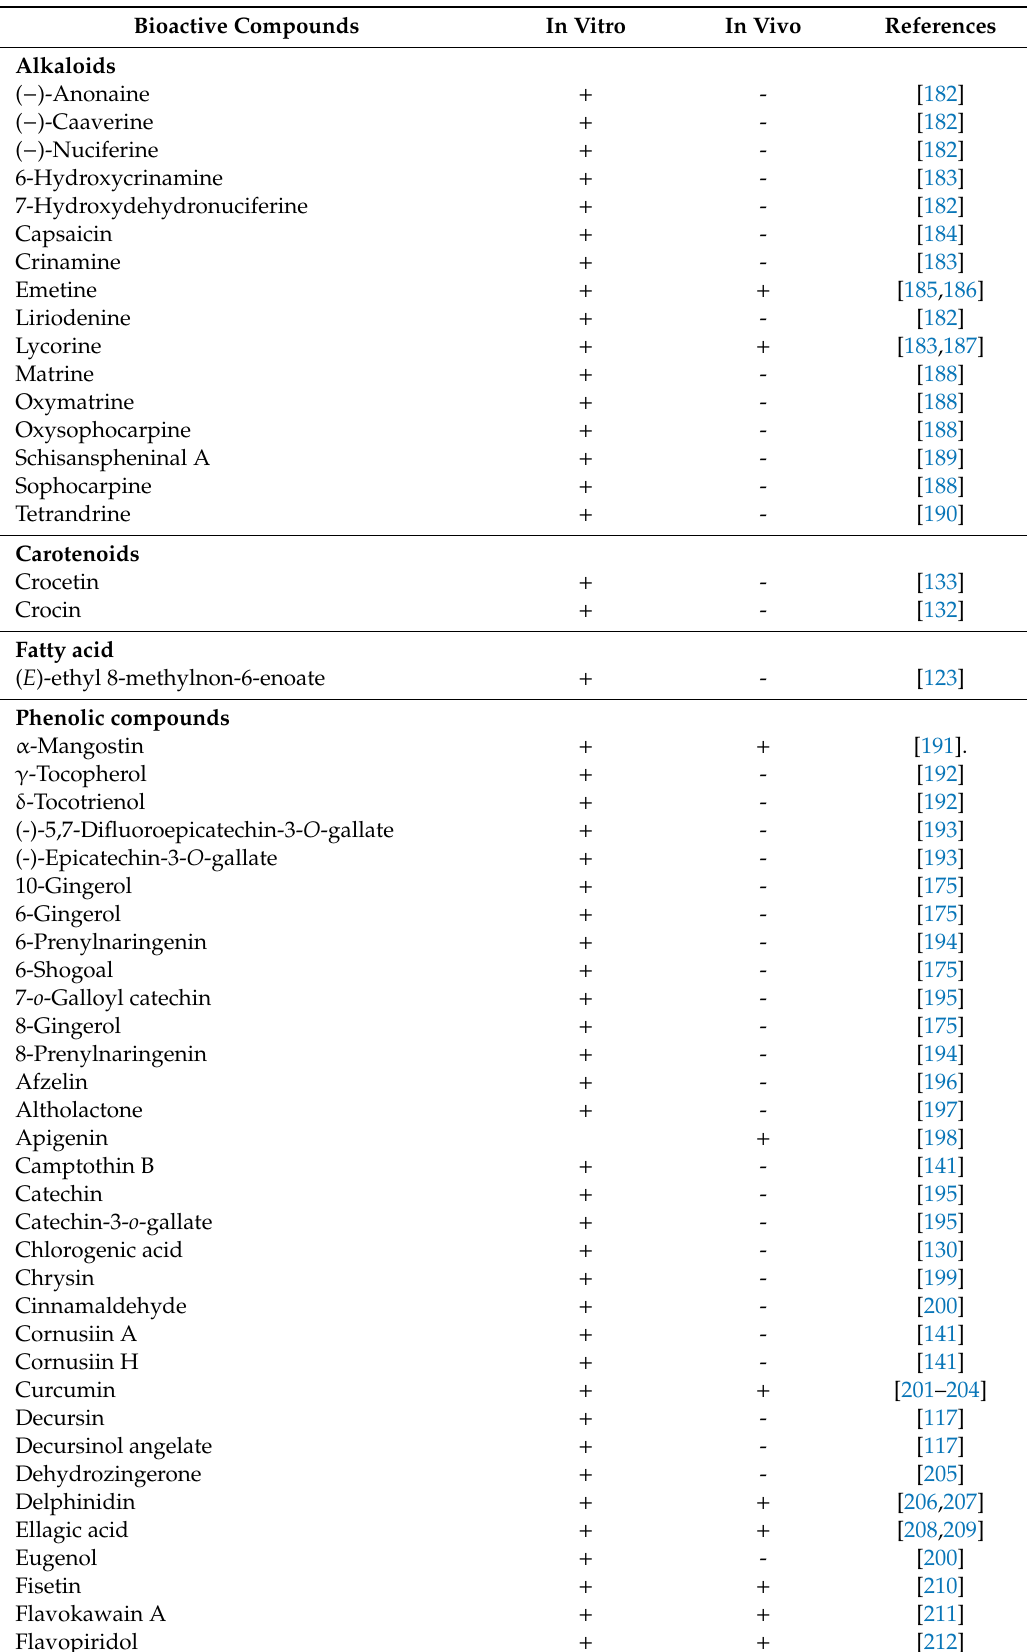
Table 4. Plant derived-compounds with anti-prostate cancer e ff